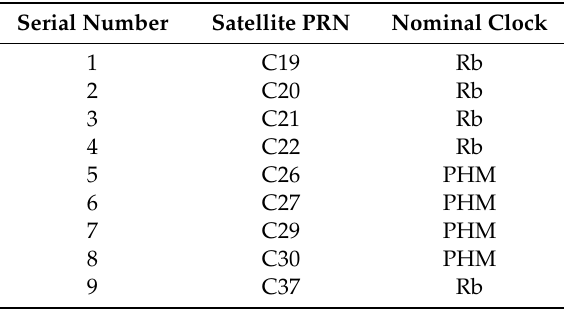
Table 1. Atomic clocks of nine BeiDou-3